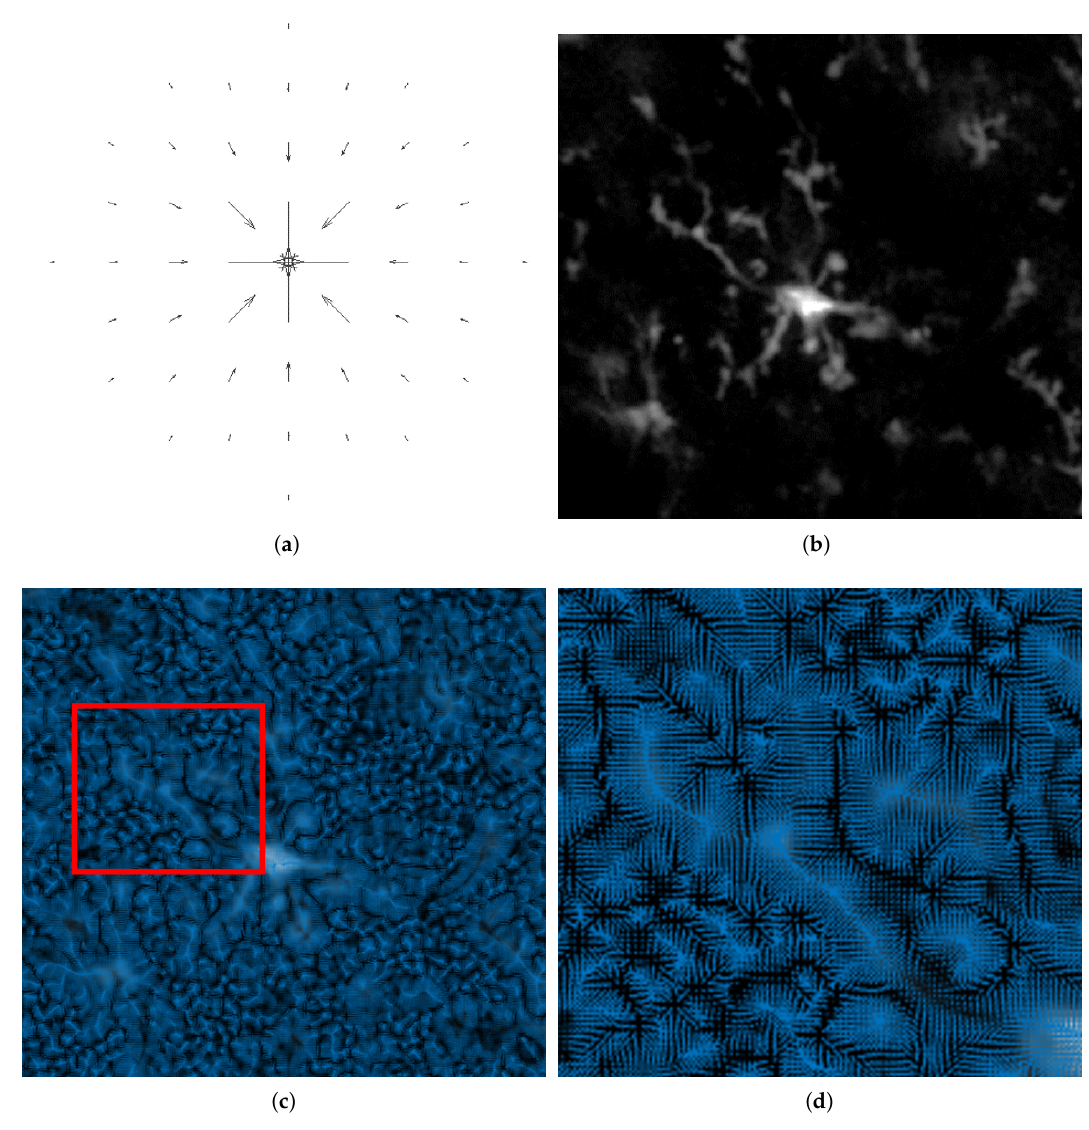
Figure 2. The VFC field of the intensity image. ( a ) The kernel is convolved with ( b ) the original image (slice 8 of 16 in the z-stack is shown) to produce VFC field. ( c ) The VFC field. ( d ) Zoomed-in VFC field of the red box in ( c